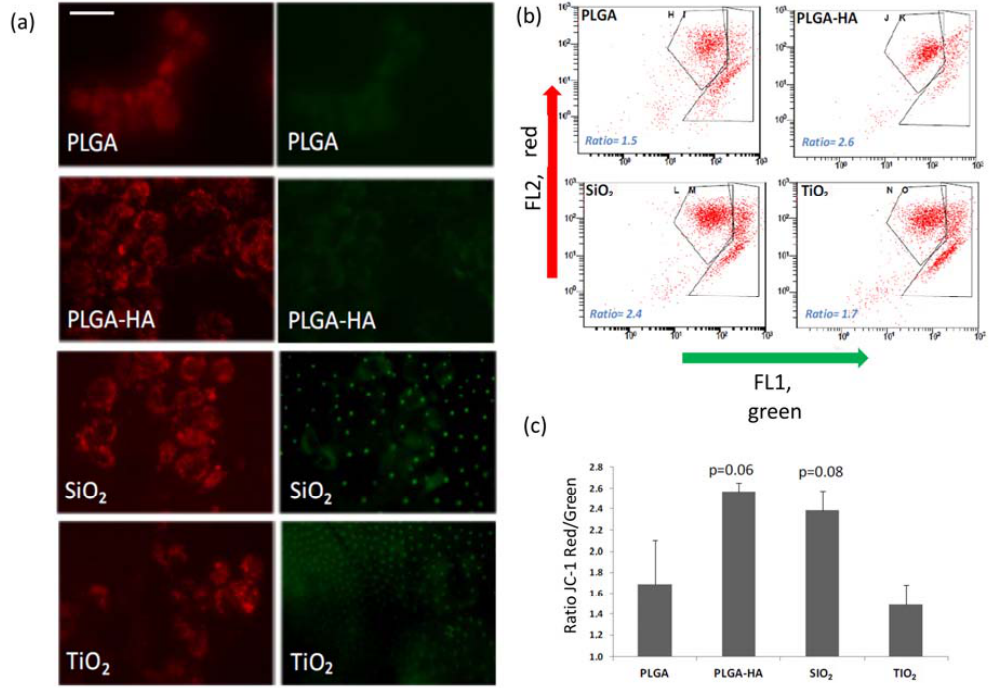
Figure 3. ( a ) Microphotography of the osteoblasts on studied membranes. ( b ) Representative histograms of the fluorescence visualization generated by the JC-1 probe by flow cytometry (FL2, red and FL1, green) on membranes. ( c ) The means + SD (standard deviation) of the ratio of the red/green fluorescence of the cells adhered to the membranes, 24 h after sowing and the value of the p-value of the Student t-test with respect to PLGA control membrane. Bar in PLGA = 10 microns (same scale for all images).